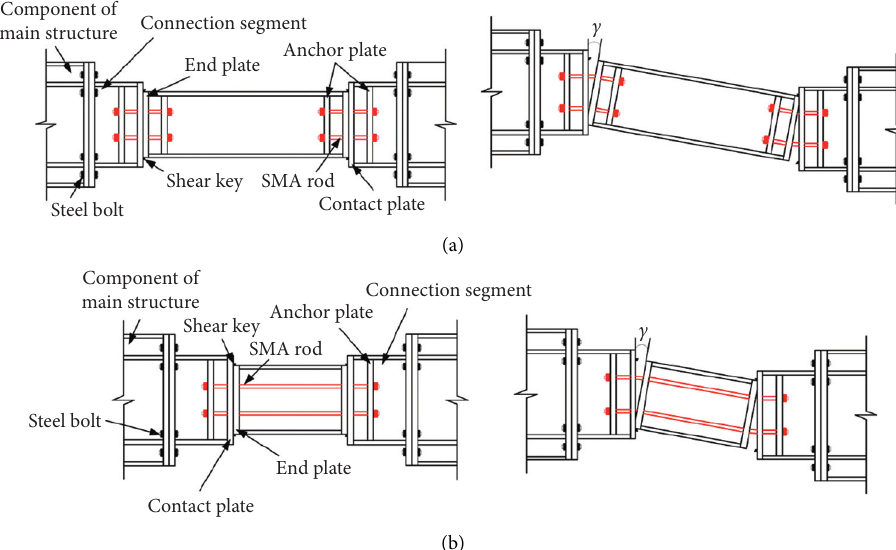
Figure 10: Geometric configuration of two proposed link beams: (a) geometric configuration of type I link; (b) geometric configuration of type II link (adapted from [49]).